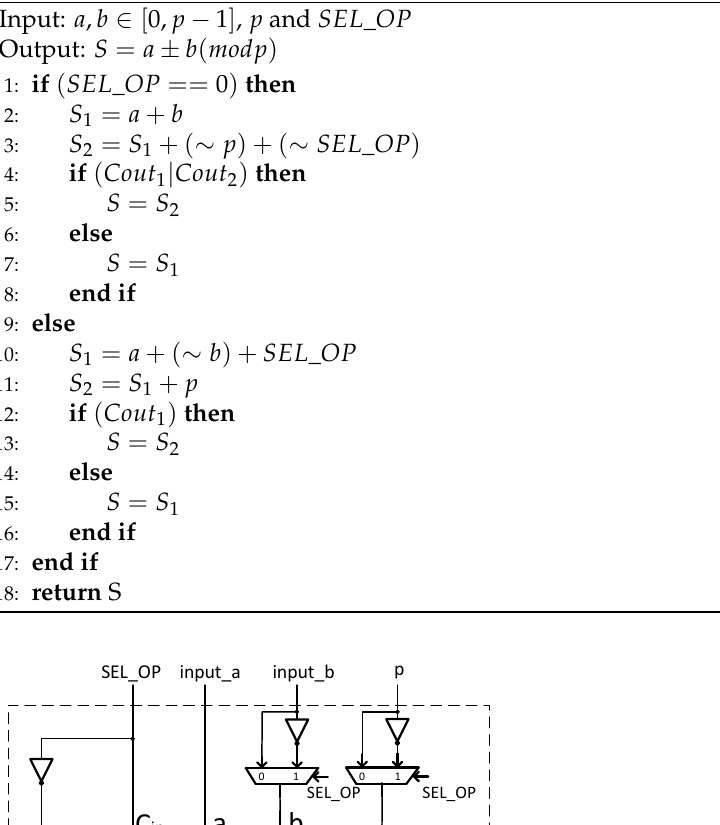
Algorithm 5 Modular Addition/Subtraction.